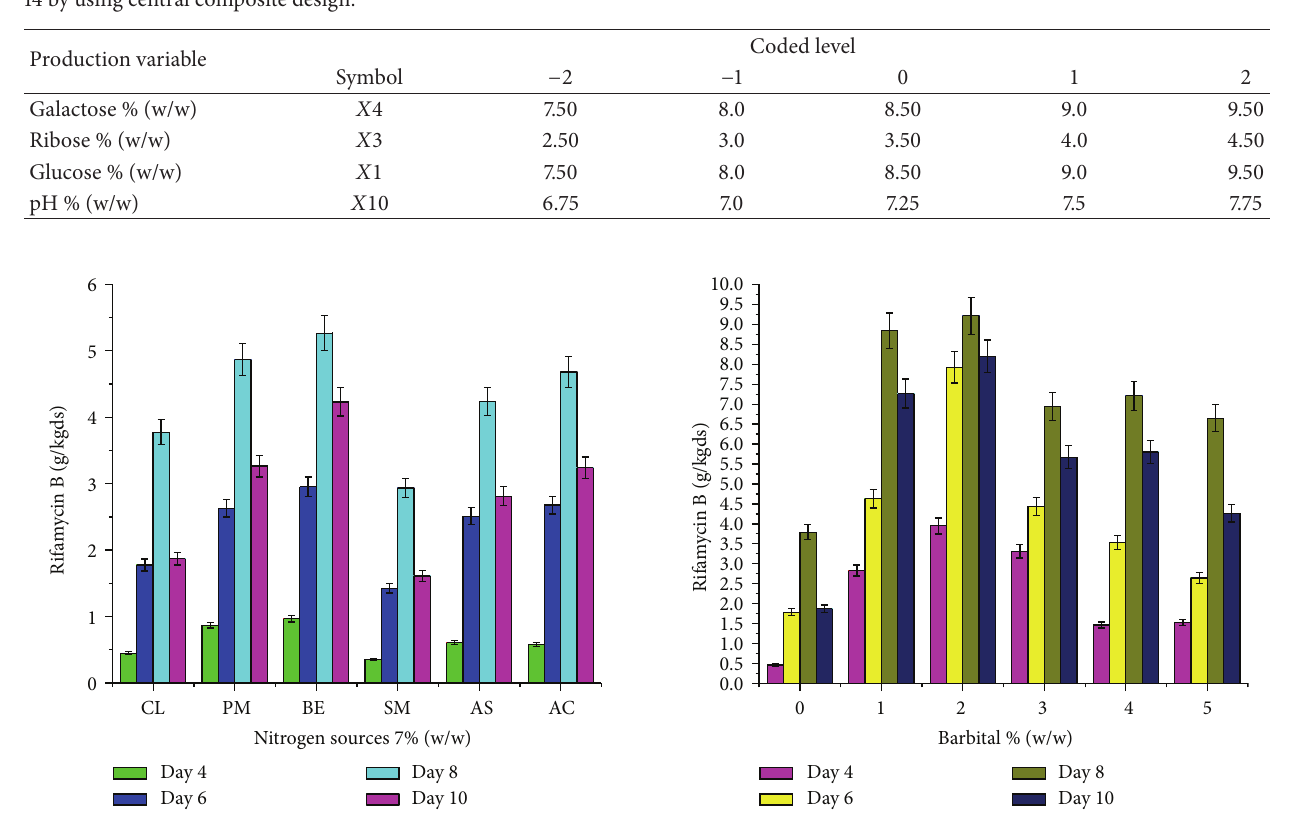
Figure 2: Effect of various nitrogen sources (7% w/w) on rifamycin B production by Nocardia mediterranei MTCC 14 using sunflower oil cake under solid-state fermentation. Cl: control, PM: peanut meal, Be: beef extract, SM: soybean meal, AS: ammonium sulphate, and AC: ammonium chloride.